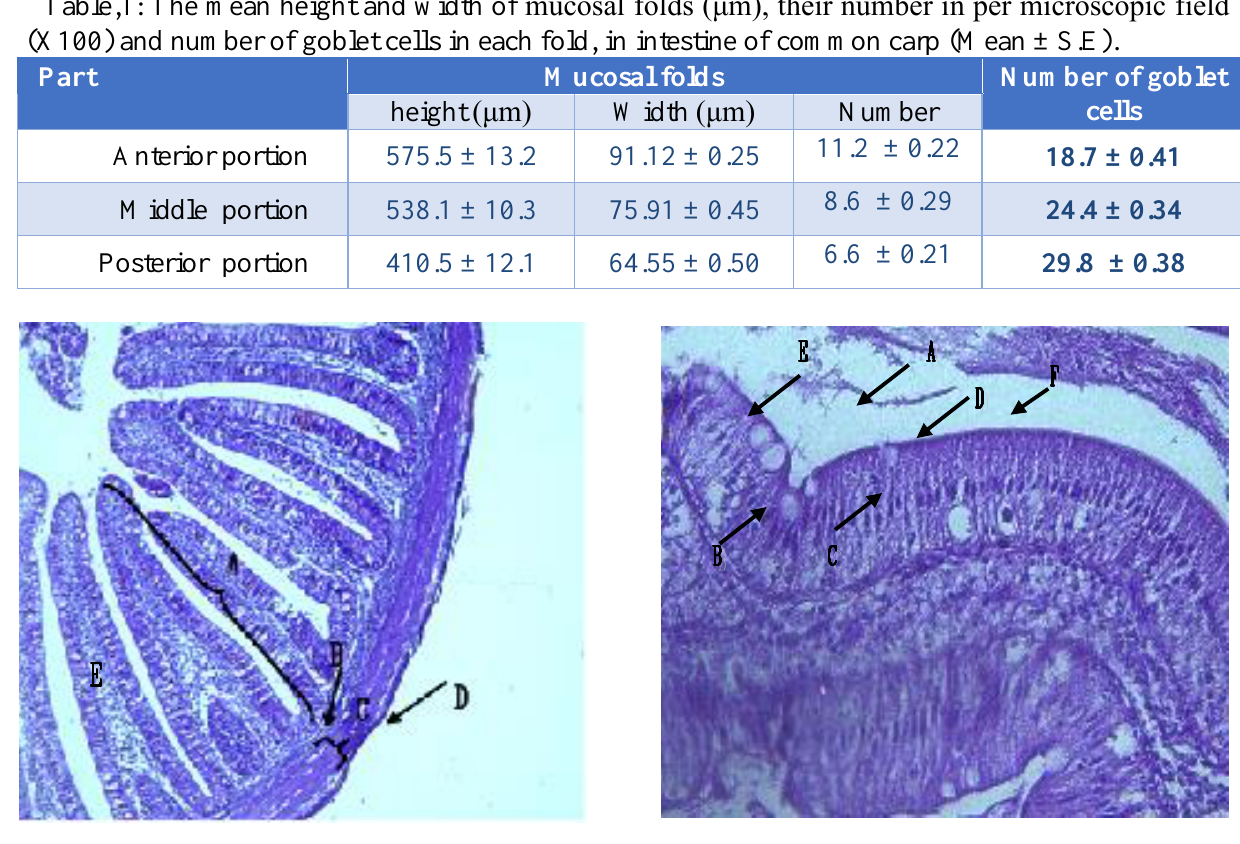
Figure, 1: Cross microscopic section of anterior portion of intestine of common carp, (A).mucosa (B).submucosa, (C). muscularis, (D). serosa, (E).fold, H & E stain (X40).